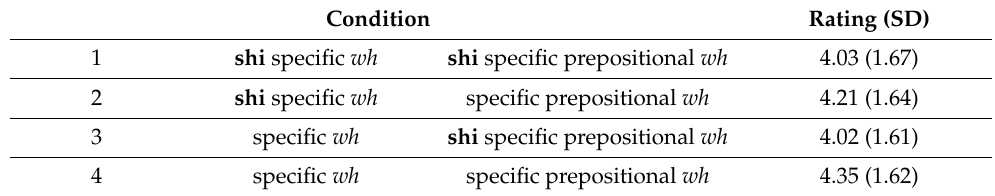
Table 13. Mean acceptability ratings in sub-experiment 4.